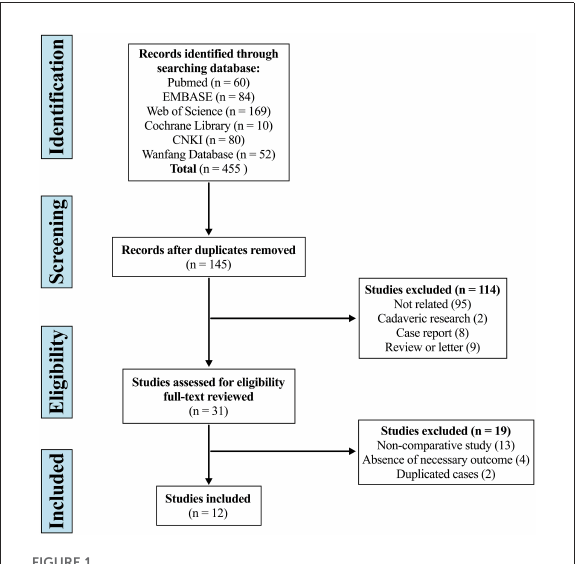
FIGURE1 Flow diagram depicting the literature review, search strategy, and selection